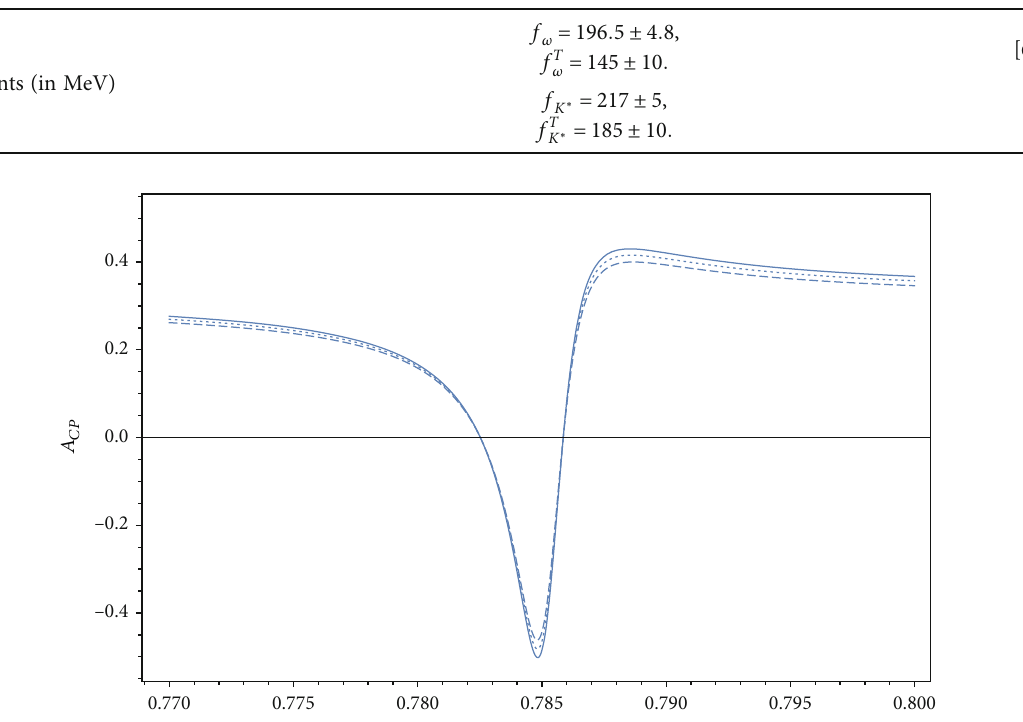
Figure 3: The CP violation, A correspond to the maximum, middle, and minimum CKM matrix elements for the decay channel of